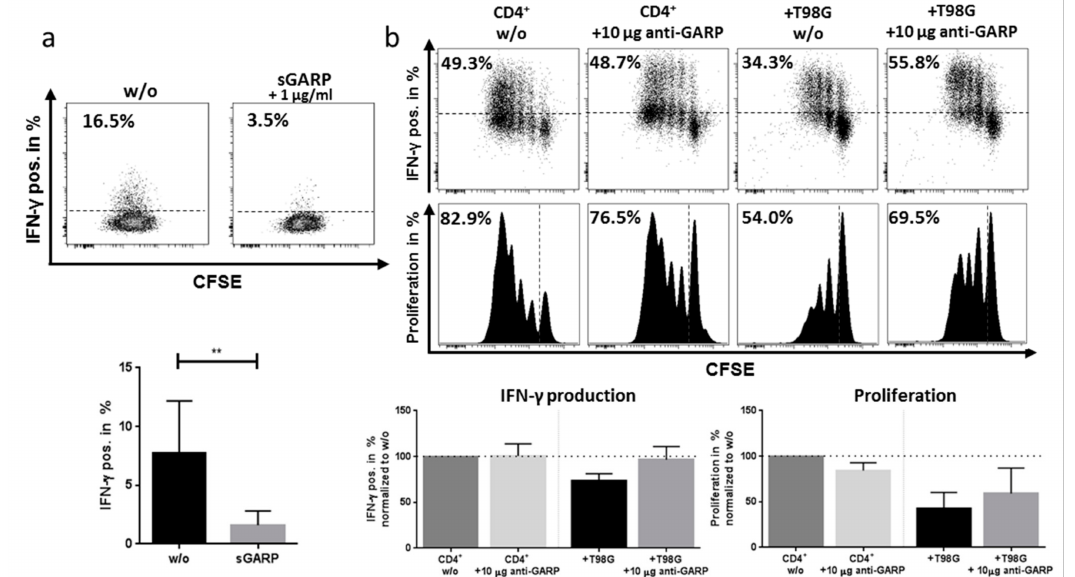
Figure 5. ( a ) Soluble GARP (sGARP) cytokine suppression. CD4 + T cells were stimulated with 1 µ g / mL anti-CD3 mAb, 1 µ g / mL anti-CD28 mAb, and with or without 1 µ g / mL sGARP for 24